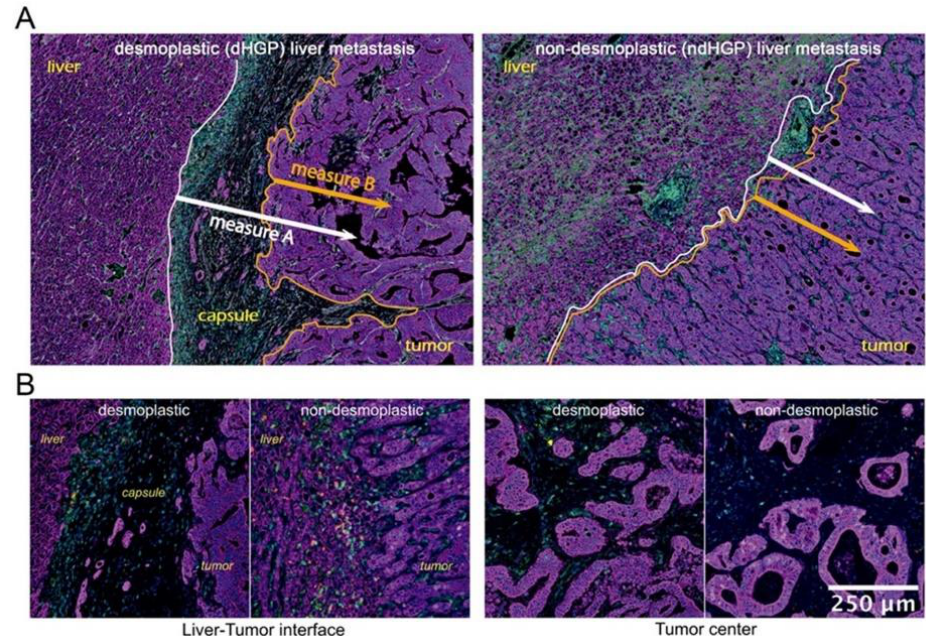
Figure 2. ( A ) Distances considered in relation to the tumor-host interface. Measure A, using as a reference the tumor-liver interface, including as part of the tumor, the fibrous capsule in case of d HGP or any small stromal area in the case of nd HGP; Measure B, using the tumor margin as a reference and then, not considering capsule or any peritumoral stromal. We use this measure throughout the manuscript to refer to the invasive margin. ( B ) Detailed magnification of the tumor/liver interface and central tumoral areas for both main histologic growth patterns.